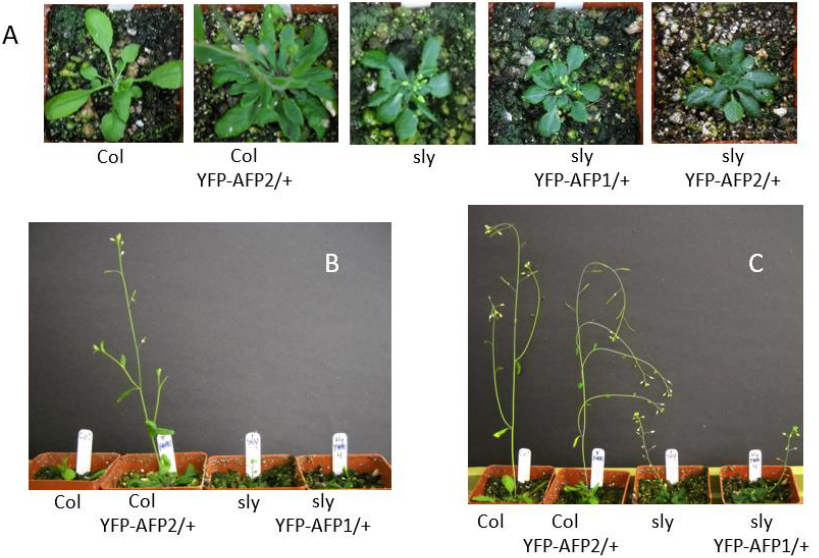
Figure 4. Effects of overexpressing YFP-AFP fusions in wild-type (Col-0) vs. sly1 mutants on vegetative growth. ( A , B ) Five-week old plants, ( C ) seven-week old plants.